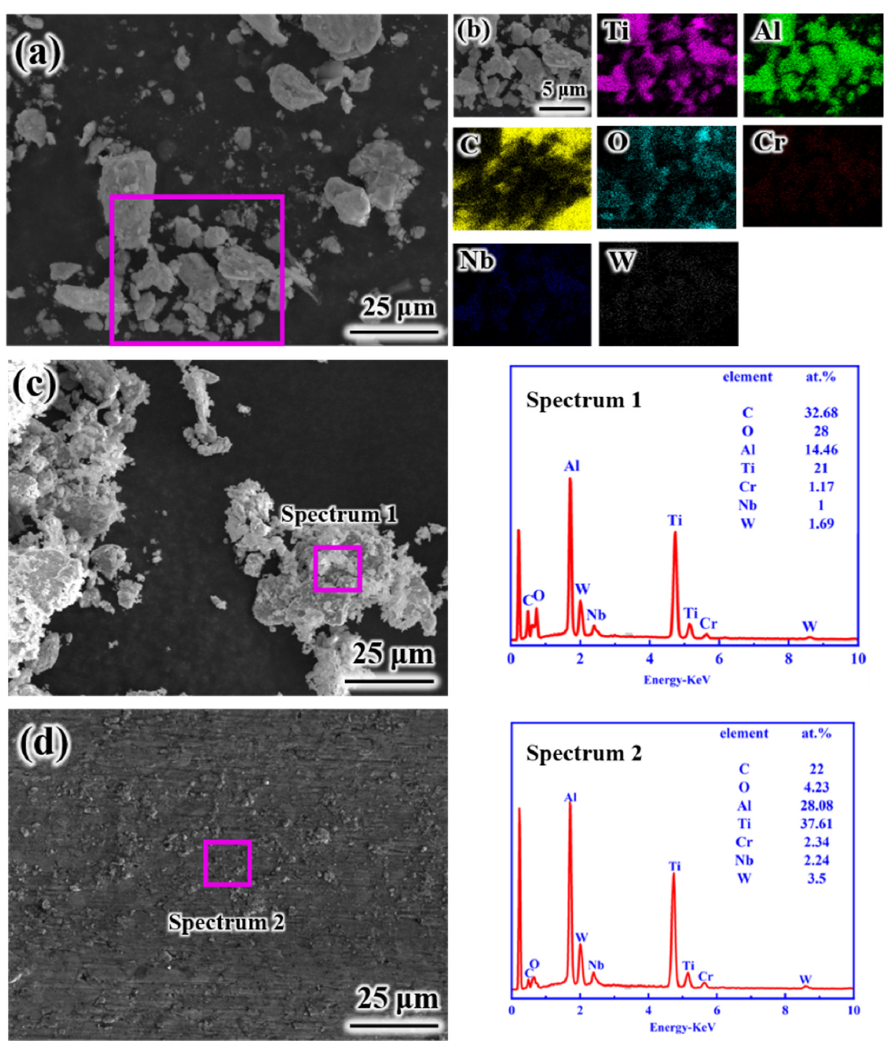
Figure 12. Wear debris morphologies of the TiAl + 10 WC composite coatings ( a , c ). ( b )Partial enlargement of the pink area of ( a ) and results of SEM ‐ Mapping. Spectrum 1 and 2 show the results of SEM ‐ EDS, and ( d ) shows frictional surface morphology of the TiAl + 10 WC composite coatings.